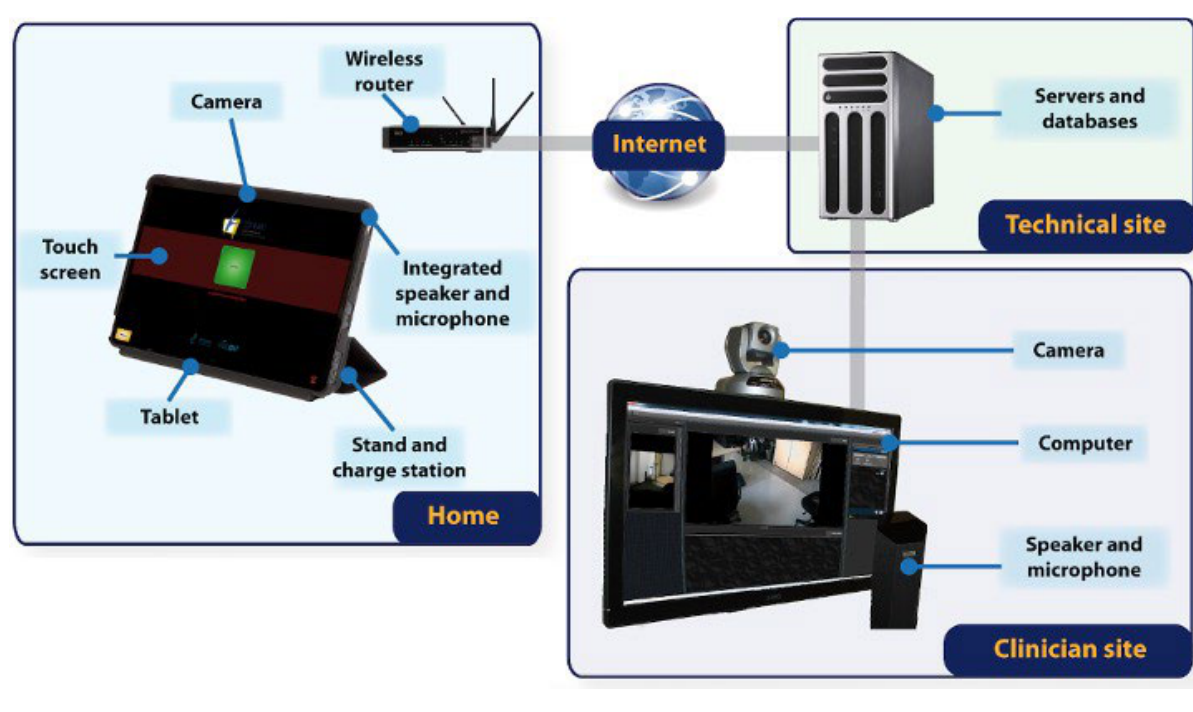
Schematic Flowchart of the Telerehabilitation